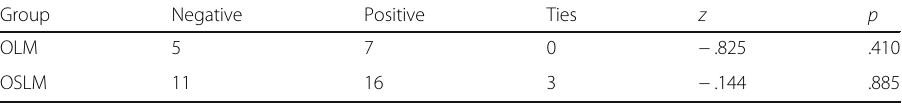
Table 8 Wilcoxon signed-rank test results of the students ’ repeated KMA scores for the OLM and OSLM groups